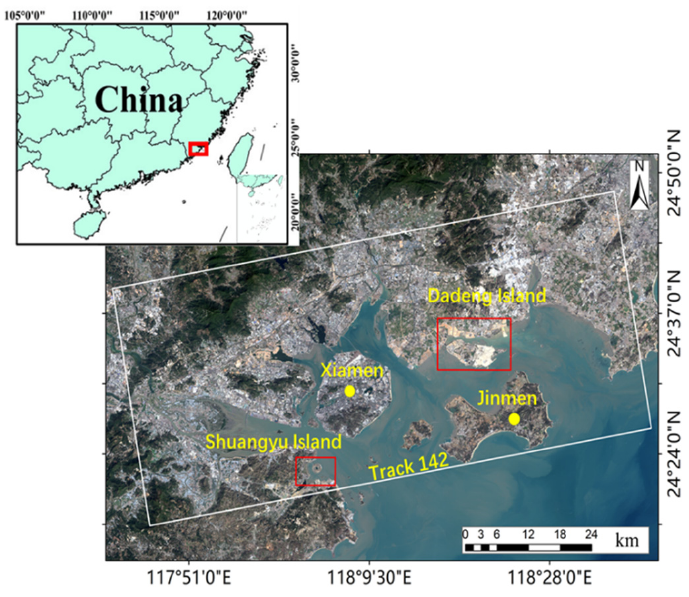
Figure 1. Study area location and the coverage of synthetic aperture radar (SAR) image. The background is the Landsat-8 image acquired on 30 January 2021.